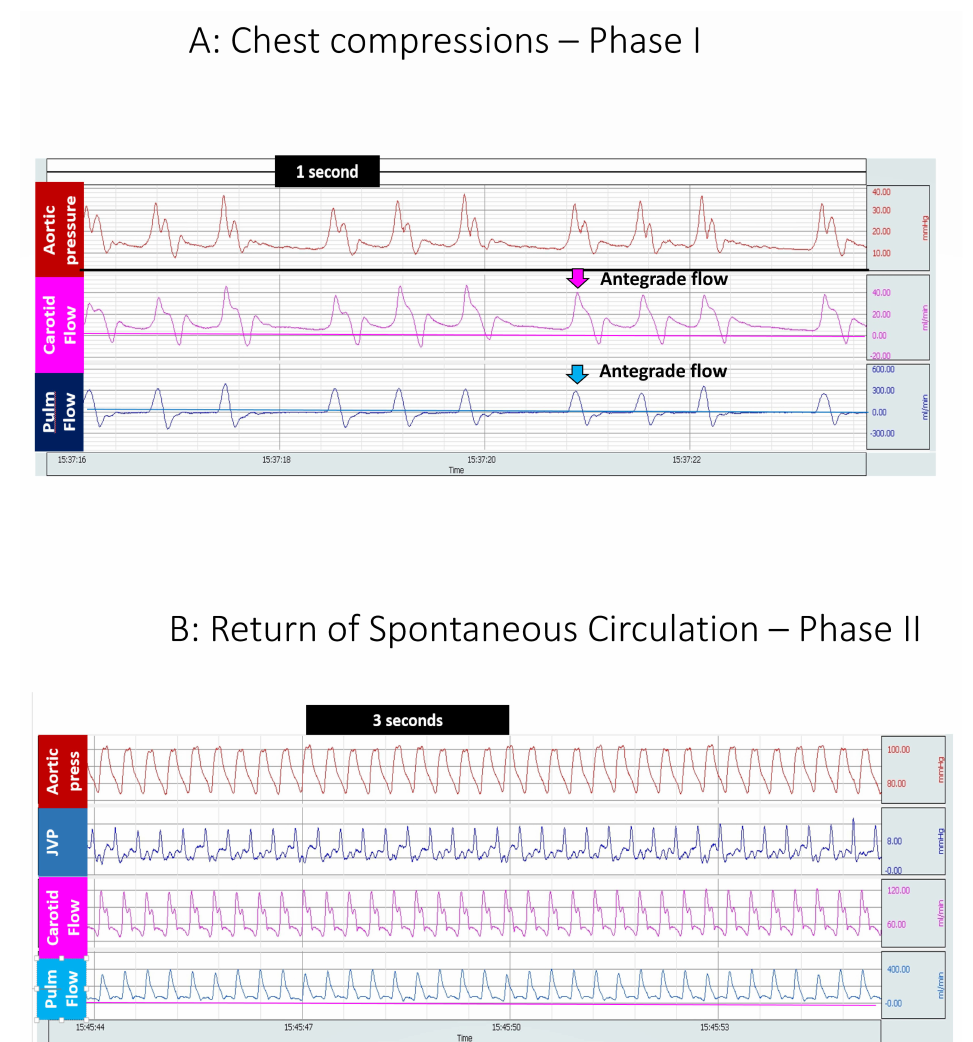
Figure 2. ( A ) BIOPAC snapshot of blood flow during the chest compression; ( B ) BIOPAC snapshot of blood flow after